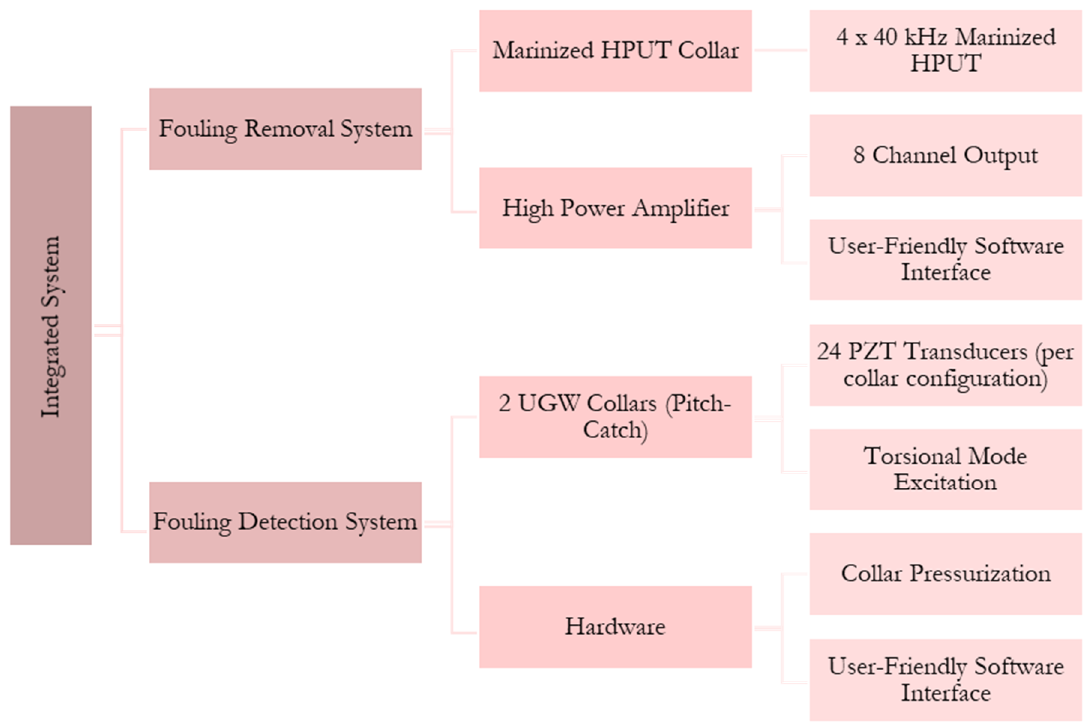
Figure 20. Integrated system architecture.